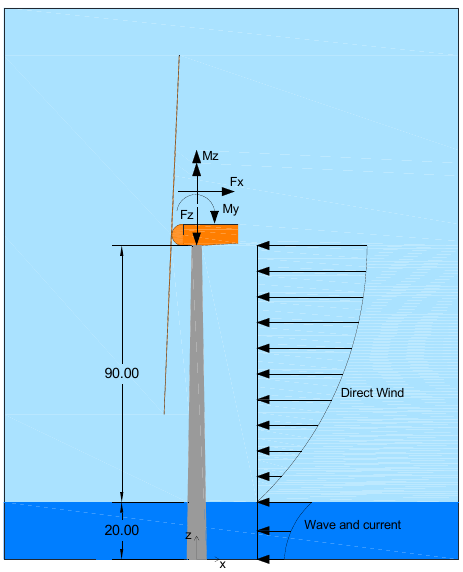
Figure 2. Applied loads (dimensions in